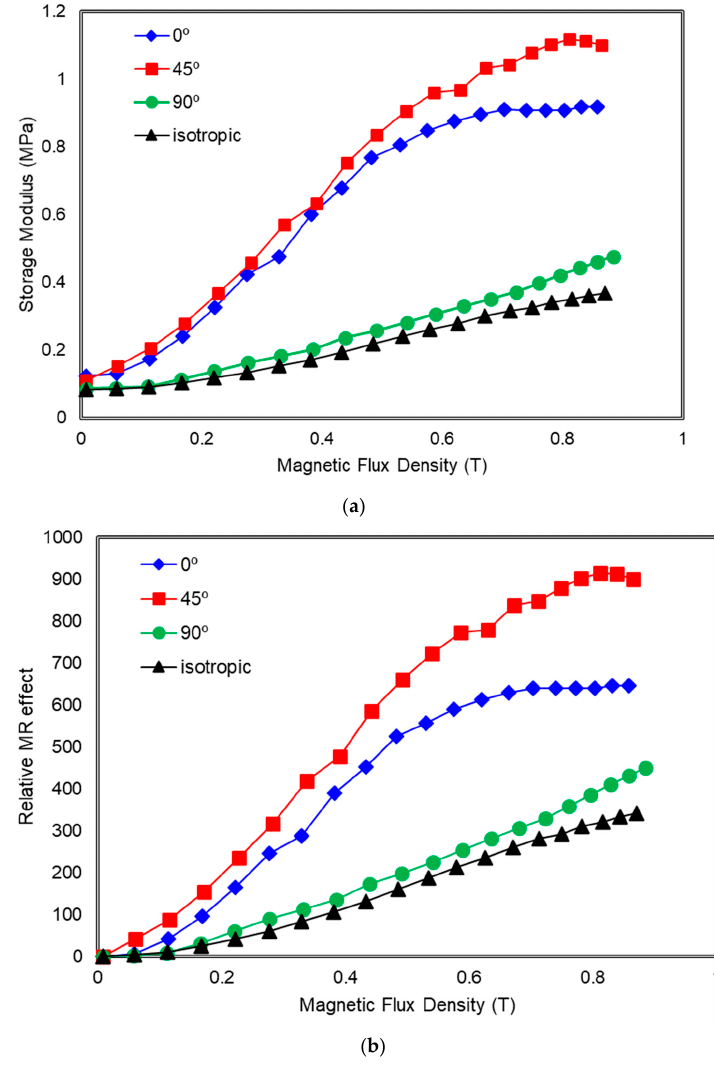
Figure 9. MRE with the various orientation mold of 0°, 45°, 90° and isotropic ( a ) Storage modulus ( b ) Relative MR Effect as a function of magnetic swept. Table 3. The initial storage modulus (G 0 ), the magnetic ‐ induce modulus ( ∆ G) and the MR effect of MRE samples with different mold orientations.